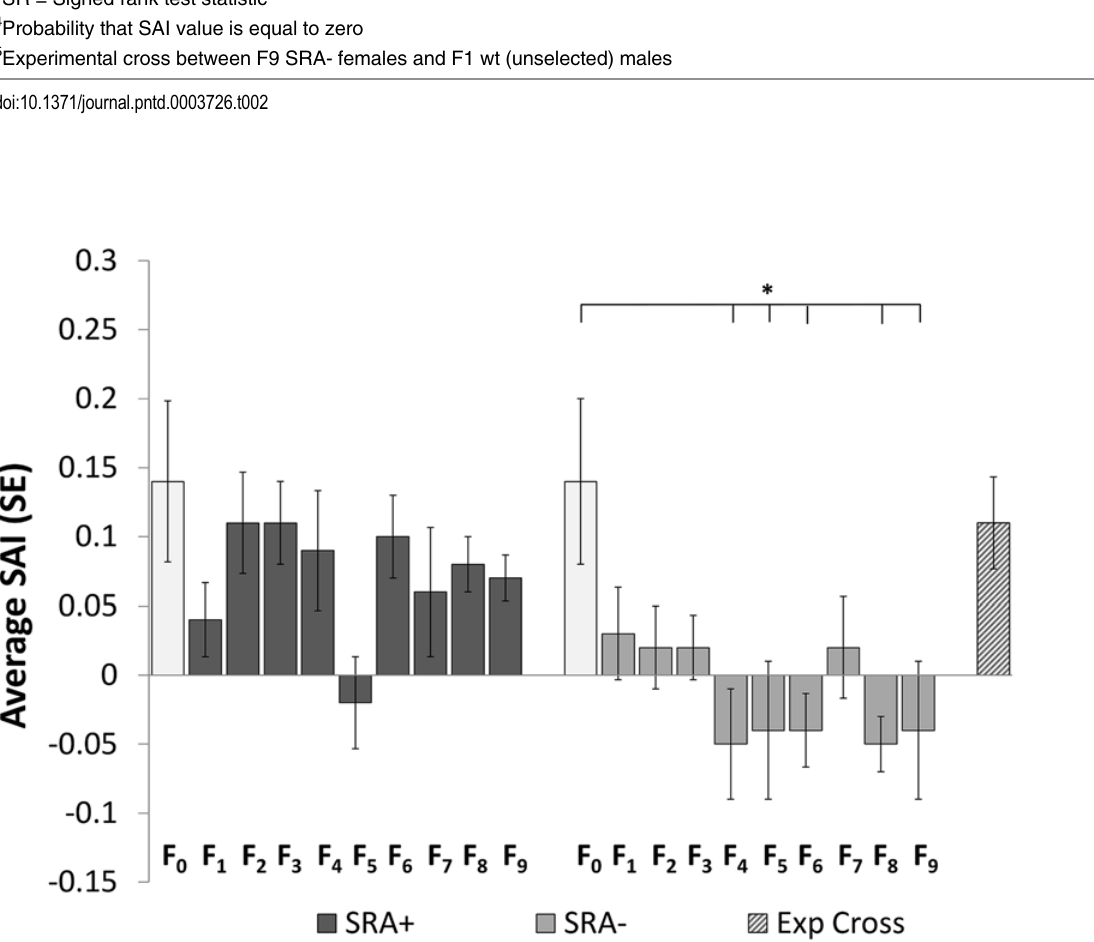
Fig 3. The heritability of spatial repellent insensitivity. Spatial activity index (SAI) values by generation in selectively bred Ae . aegypti responder (SRA+) and non-responder (SRA-) strains. * = SAI values significantly different from the baseline F 1 generation via ANOVA with Dunnett ’ s test for multiple comparisons, α = 0.05. Exp Cross = F 9 SRA- females mates with F 1 wt